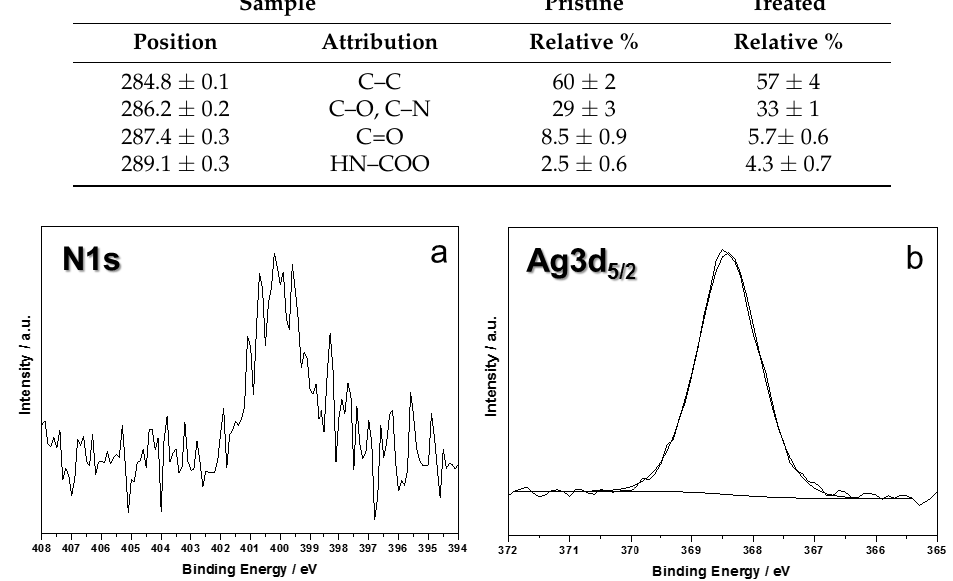
Figure 3. N1s ( a ) and Ag3d 5/2 ( b ) XP-HRR of treated leather.